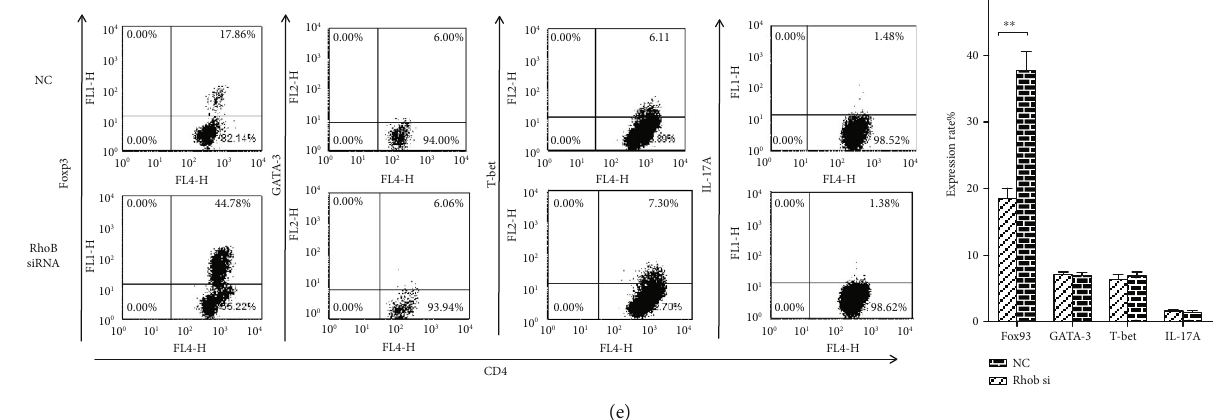
Figure 6: miR-223-3p suppresses Rhob expression to downregulate antigen endocytosis and presentation of BMDCs, followed by Treg cell polarization. (a, b) Mouse immature DCs were transfected with the miRNA mimic control, miR-223-3p mimic, miRNA inhibitor control, and miR-223-3p inhibition, at a fi nal concentration of 50 nM. After 24 h, DCs were stimulated with 100 μ g/ml OVA for 24h. Cell lysates were subjected to Western blot analysis for Rhob, CDC42, Rhoa, and Rac-1 proteins. (c – e) Immature mouse DCs were transfected with 50 nM siRNA-Rhob or siRNA control. (c) After 24 h of transfection, endocytic activity (FITC-OVA uptake) of BMDCs was measured by fl ow cytometry. (d) After 24h of transfection, DCs were stimulated with 100 μ g/ml OVA for 24 h and then stained with MHC-II antibody, followed by fl ow cytometry analysis. The bar chart indicated the MFI in the gate of CD11c+ cells in each group. (e) After 24h of transfection, DCs were stimulated with 100 μ g/ml OVA for 24h. Puri fi ed CD4+ T cells were cocultured with the transfected DCs at a ratio of 1:10 (DC/T cells). After 4 d, cells were collected and stained with anti-CD4-APC, followed by intracellular staining with FITC- conjugated anti-Foxp3, FITC-conjugated anti-IL-17A, PE-conjugated anti-GATA-3, or PE-conjugated anti-T-bet, respectively. The cells were then analyzed by fl ow cytometry. The bar chart indicated the speci fi c transcription factor of T cells in the gate of CD4+ cells in each group. Data were presented as mean ± SD of three independent experiments. t -test, ∗ P < 0 : 05 , ∗∗ P < 0 : 01